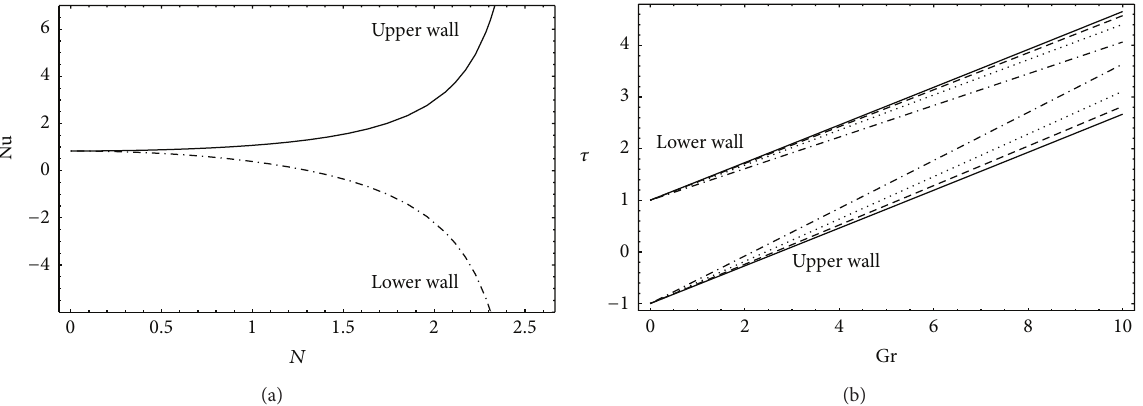
Figure 9: (a) Nusselt number for 𝑎 = 0.6 , 𝑏 = 1.2 , 𝑑 = 2 , 𝜙 = 0 , 𝑏 𝑠 = 0.01 , and 𝑥 = 𝜋 , (b) skin friction for 𝑎 = 0.7 , 𝑏 = 1.2 , 𝑑 = 2 , 𝜙 = 0 , = 0.01 , 𝑥 = 𝜋/4 , 𝑛 = 2 , 𝜃 = 1.8 , 𝑏 𝑠